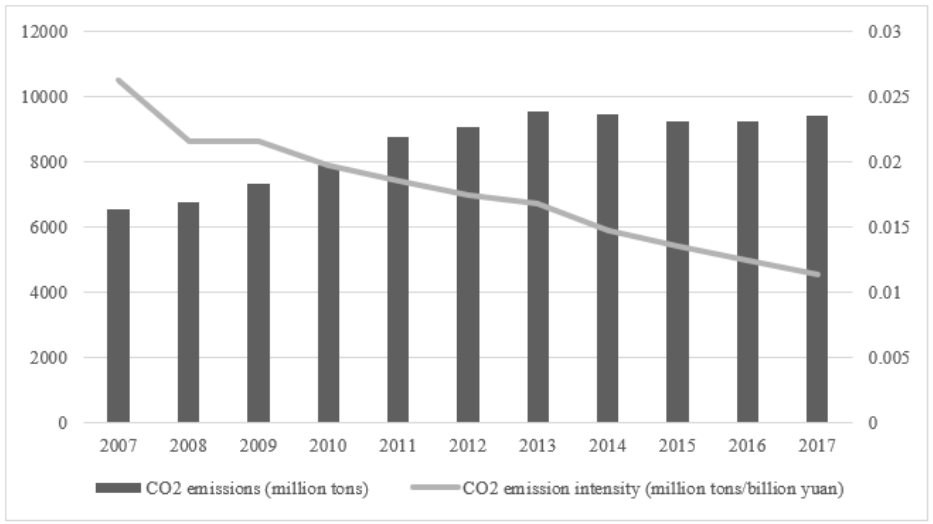
Figure 4. CO2 emissions and intensity (2007 –